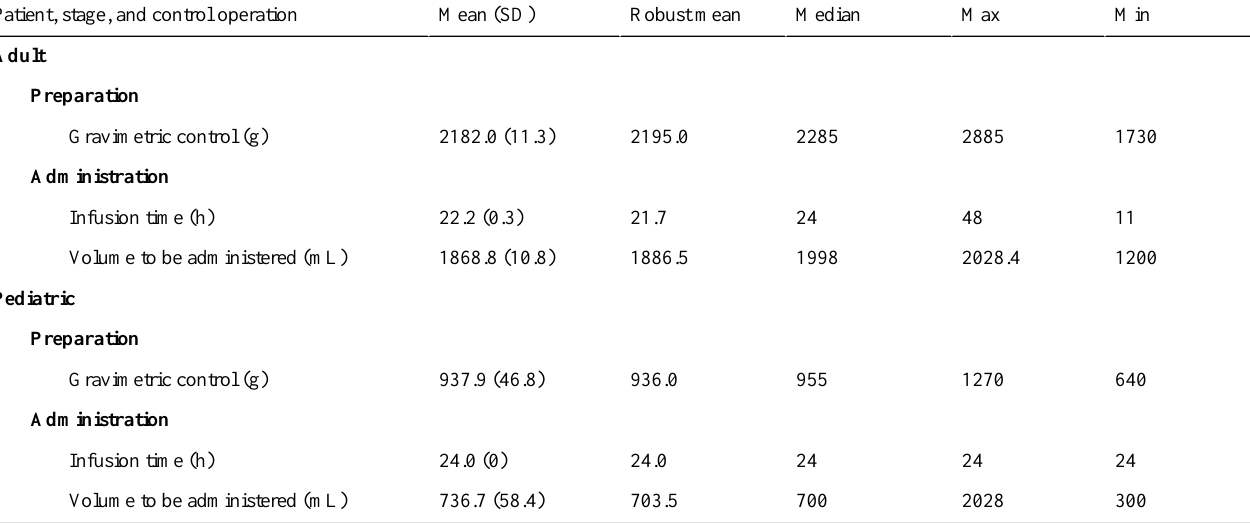
Table 3. Statistics regarding the control operations identified as critical control points in the management system and the traceability control of parenteral